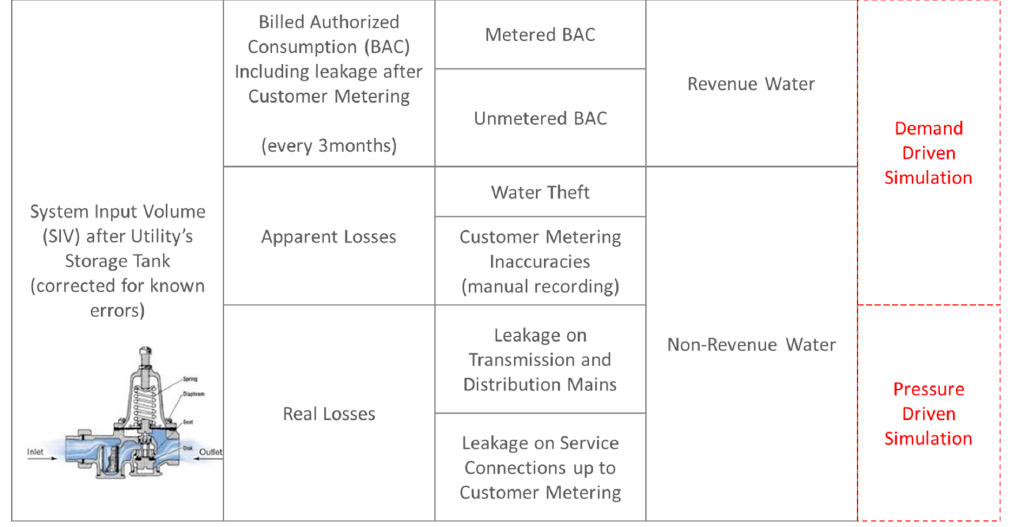
Figure 6. SIV components as specified for the Skiathos case study and the respective simulation